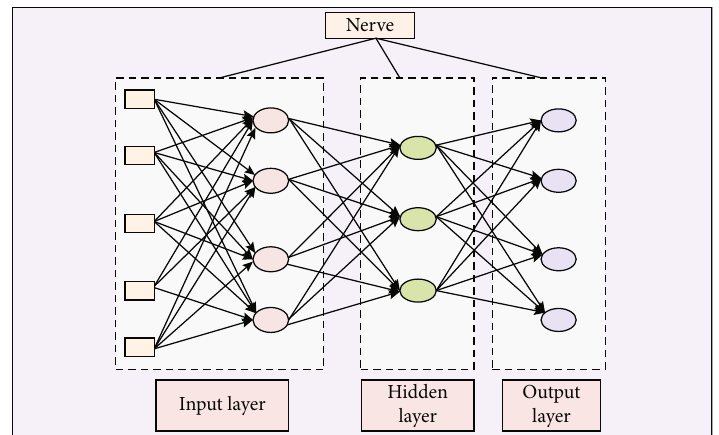
Figure 1: Schematic diagram of neural network